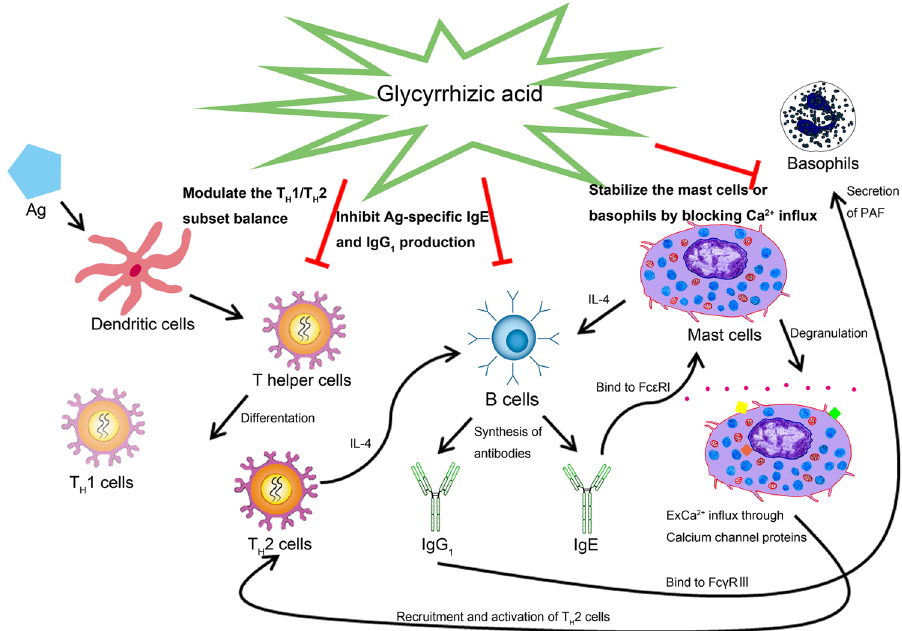
Figure 7. The mechanism of anti-allergic effect of GA on the IgE-mediated allergic